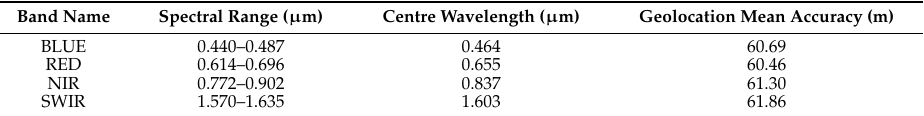
Table 3. Characteristics of Proba-V spectral